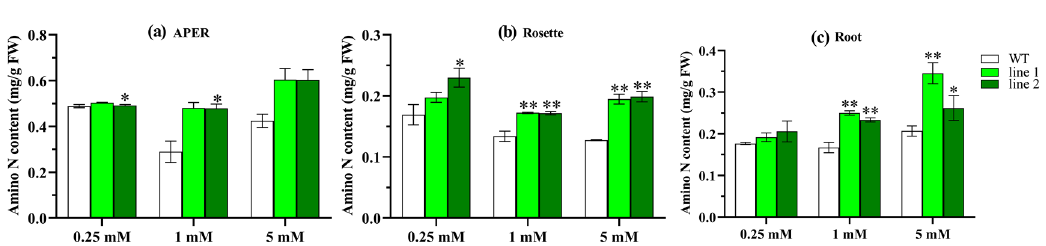
Figure 7. The content of amino N in overexpression Arabidopsis (OE) and wild type (WT). ( a ) The amino N content in aerial part excluding rosette (APER). ( b ) The amino N content in rosettes (Rosette). ( c ) The amino N content in roots (Root). 0.25 mM N, 0.125 mM NH 4 NO 3 ; 1 mM N, 0.50 mM NH 4 NO 3 ; 5 mM N, 2.50 mM NH 4 NO 3 . Values are means ± standard (SD) ( n = 3). Asterisks indicate significant difference between WT and two OE lines (line 1, line 2). * p < 0.05; ** p < 0.01 ( t -test).